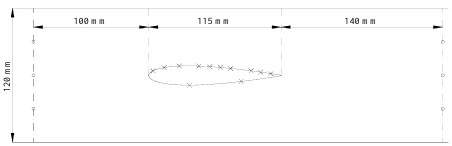
Figure 3. Parameters of experimental test.